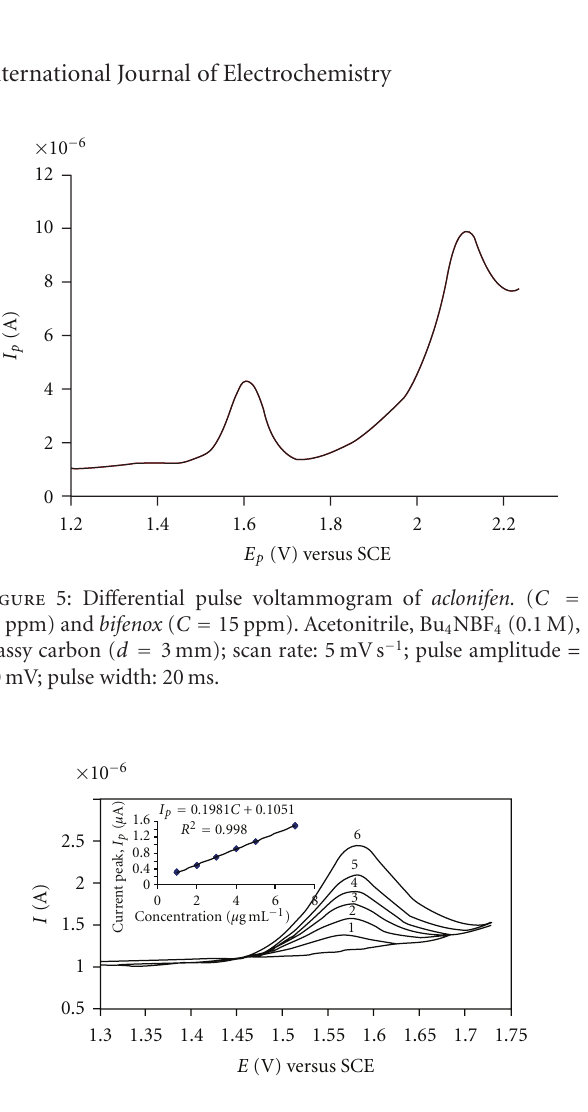
Figure 6: Di ff erential pulse voltammograms of aclonifen in ace- tonitrile, Bu 4 NBF 4 (0.1M), glassy carbon ( d = 3mm); scan rate: 5mVs − 1 ; pulse amplitude = 50 mV; pulse width: 20ms. C = 1 − 7 μ